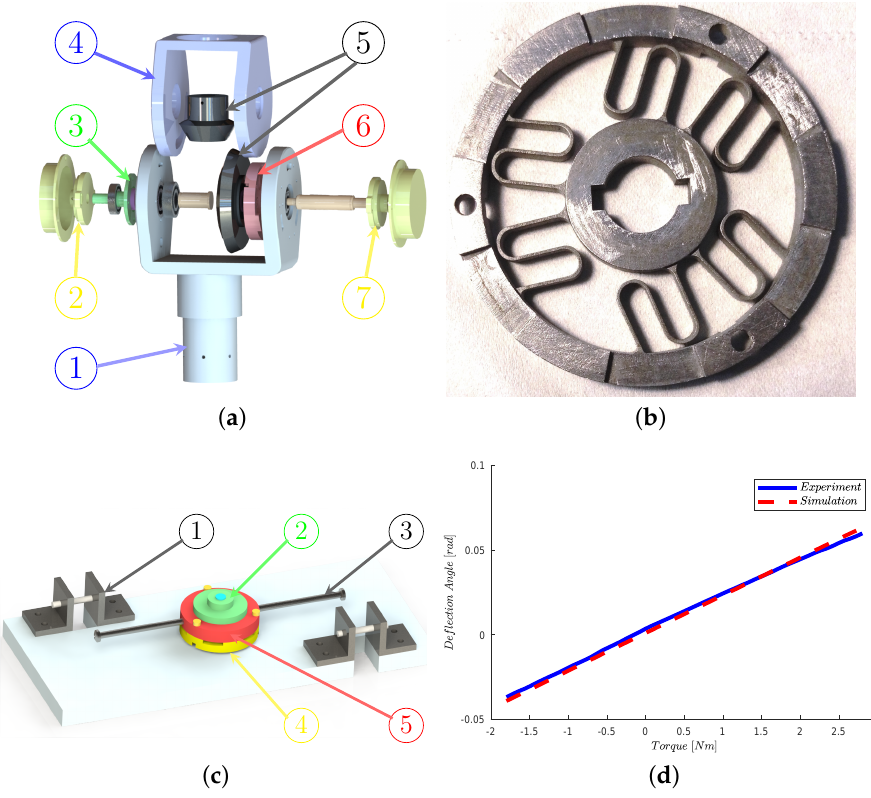
Figure 4. ( a ) Configuration of the compact elastic module; 1: Shank segment, the torsional